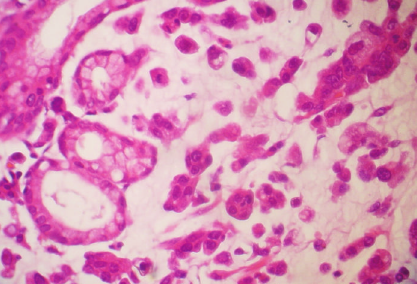
Figure 1: Microscopic scheme of metastatic diffuse type gastric cancer.